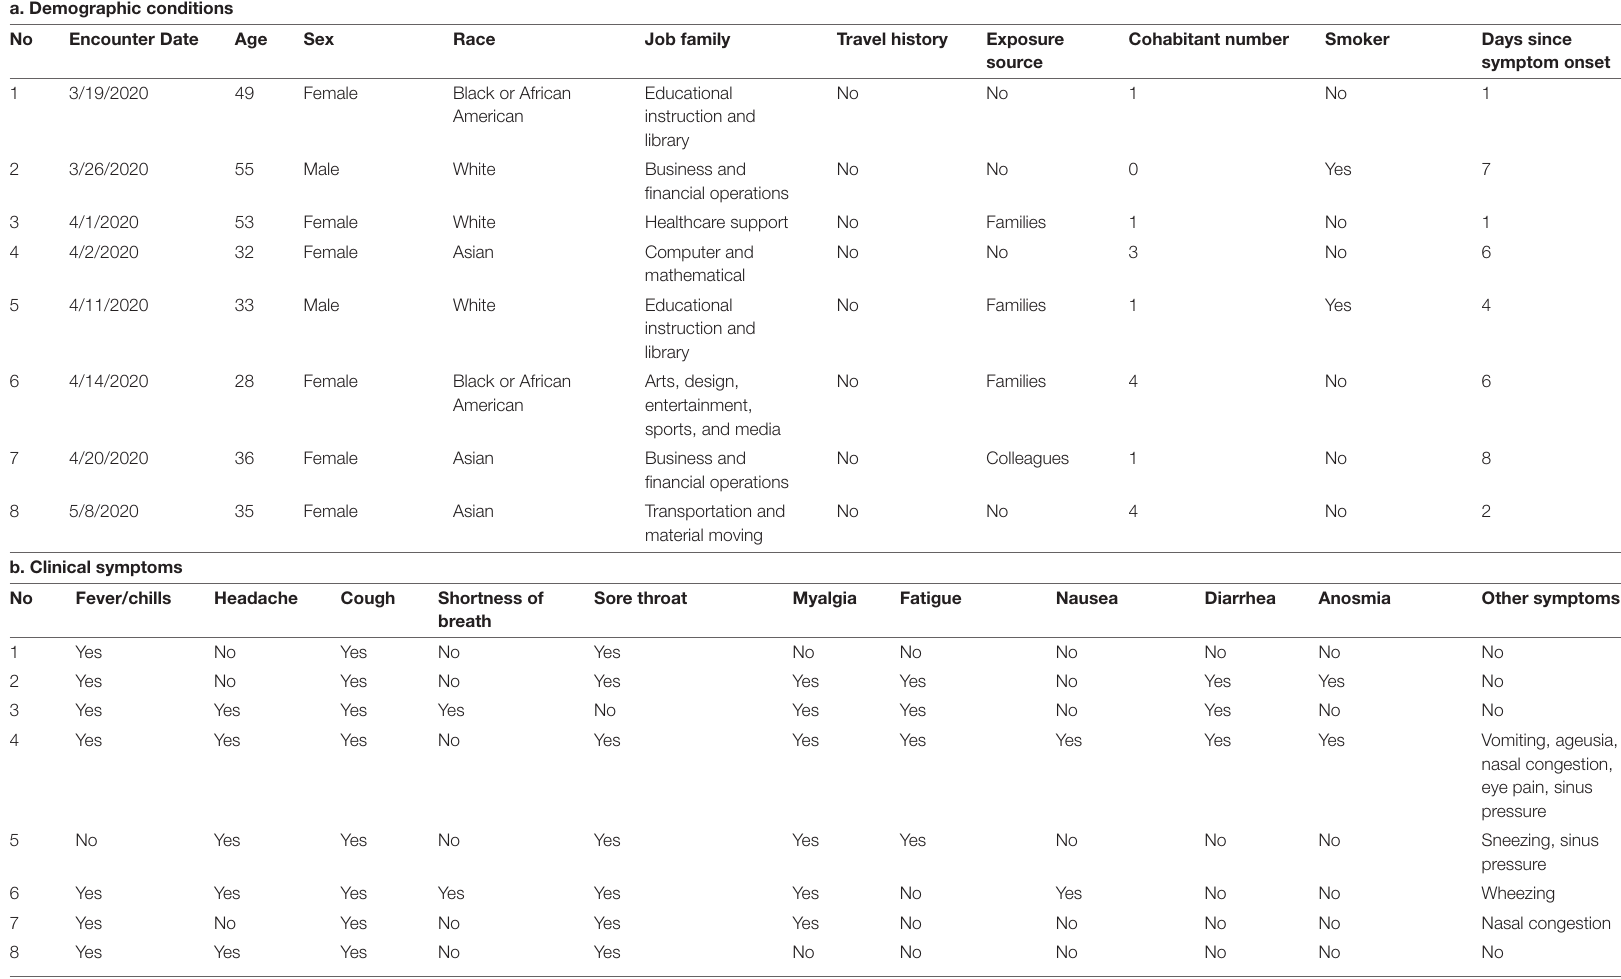
RT-PCR, Reverse transcription polymerase chain